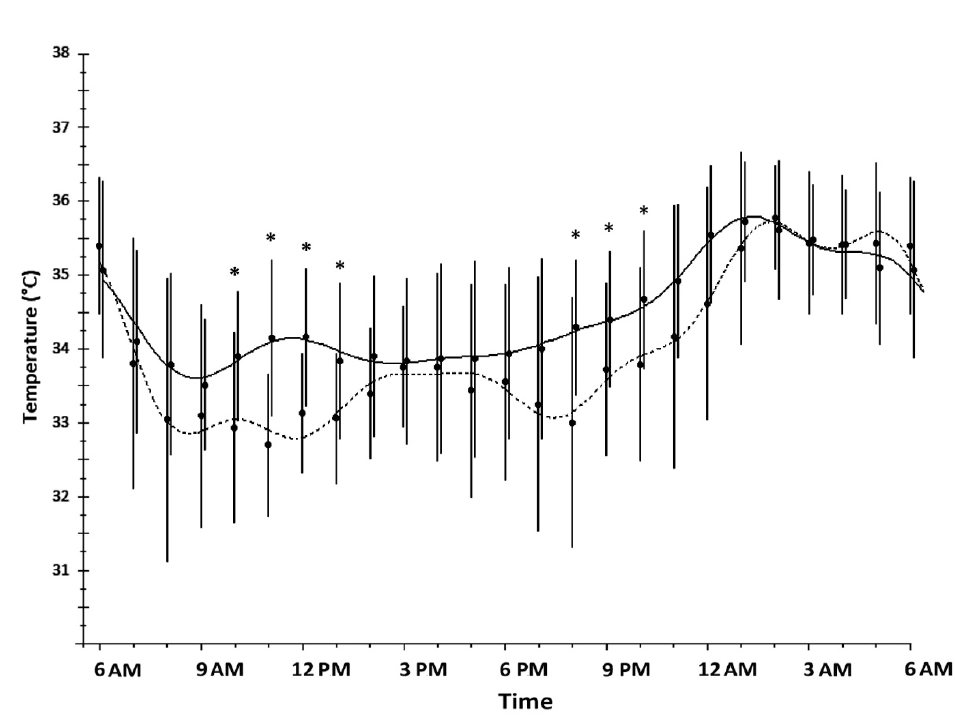
Table 2. Results of Cosinor analysis of wrist skin temperature of shift-working (SW) and daytime (DT) nurses.